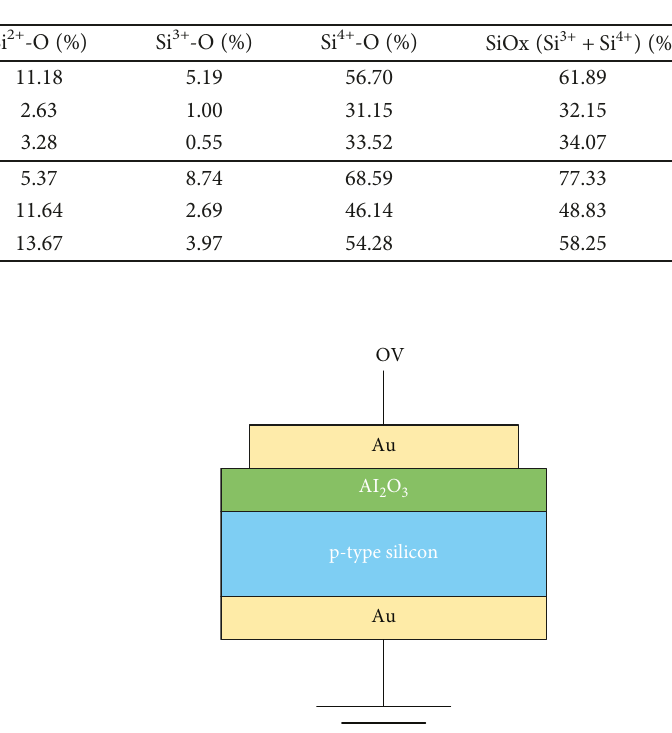
Table 2: The calculated ratio of silicon oxide subpeaks and total ratio of SiO 120min; criteria are based on Si peak.